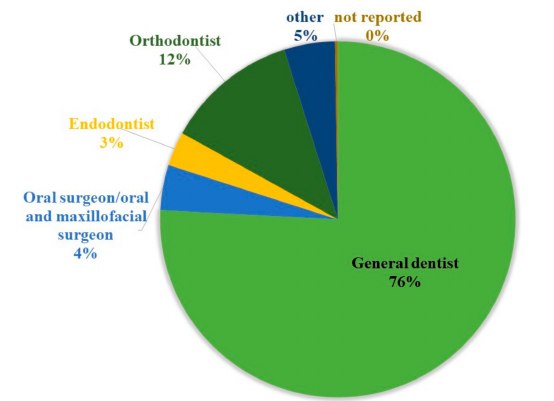
Figure 1. Distribution of dental specialisms from the participating dentists ( n =